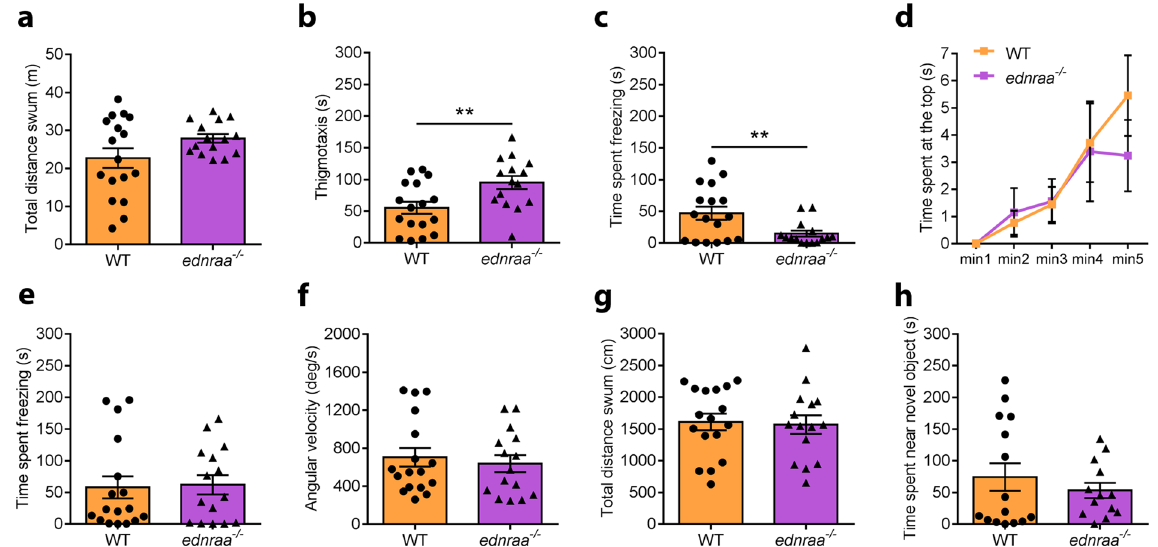
Figure 4. Non-social behaviour of ednraa − / − . ( a) Open field test. ednraa − / − and WT swim a similar distance in the open field test. In this test ednraa − / − display (b) increased thigmotaxis and (c) decreased freezing compared to WT. (d) Novel tank test. ednraa − / − spend a similar amount of time in the top third of a novel tank as WT. (e) Freezing, (f) angular velocity and (g) distance swum in the novel tank test are also similar in WT and ednraa − / − . (h) Time spent near to a novel object is similar in WT and ednraa − / − . ** p < 0.01. Each dot represents one fish.